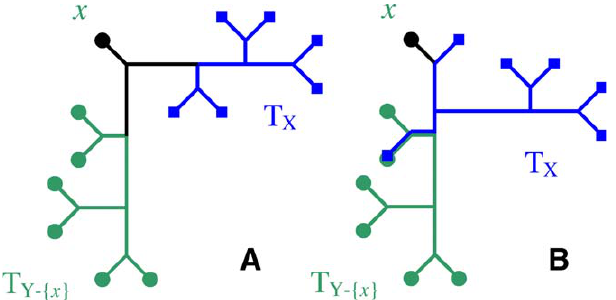
Figure 3. Representative Examples for Two Scenarios in the Proof of the Lemma In both examples, T X is in blue and T Y- f x g in green, and species (leaves) in Y are represented by filled circles. The two scenarios in the proof of the lemma, A and B, are illustrated correspondingly in (A) and (B),